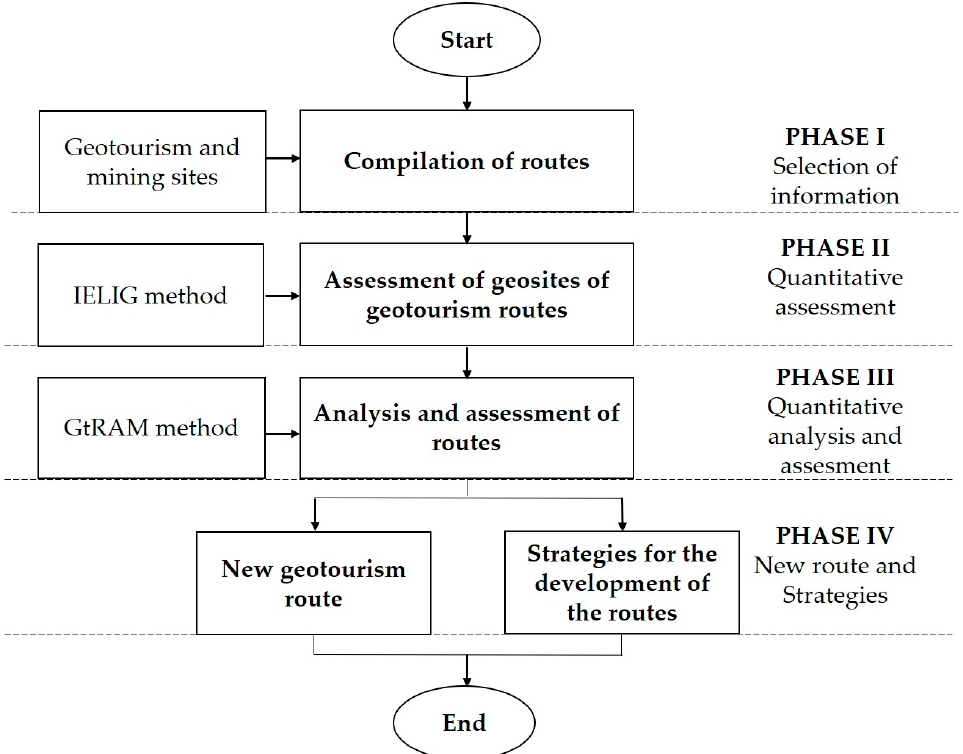
Figure 3. Scheme of the methodology followed in this study.